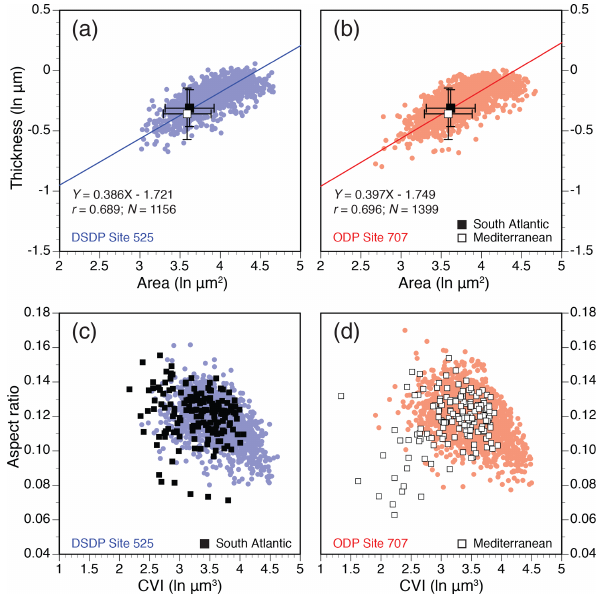
Figure 3. Coccolith allometry in modern strains and fossil spec- imens of H. carteri . (a–b) Natural log-transformed (ln) coccol- ith surface area (µm 2 ) vs. thickness (µm) for all individual fossil specimens at sites 525 (blue; N = 1156) and 707 (red; N = 1399) and mean ( ± 1SD) values for South Atlantic (black square) and Mediterranean (open square) strains; (c–d) coccolith volume index (CVI; lnµm 3 ) vs. aspect ratio (AR; unitless). Here, individual spec- imens are also shown for the modern strains.